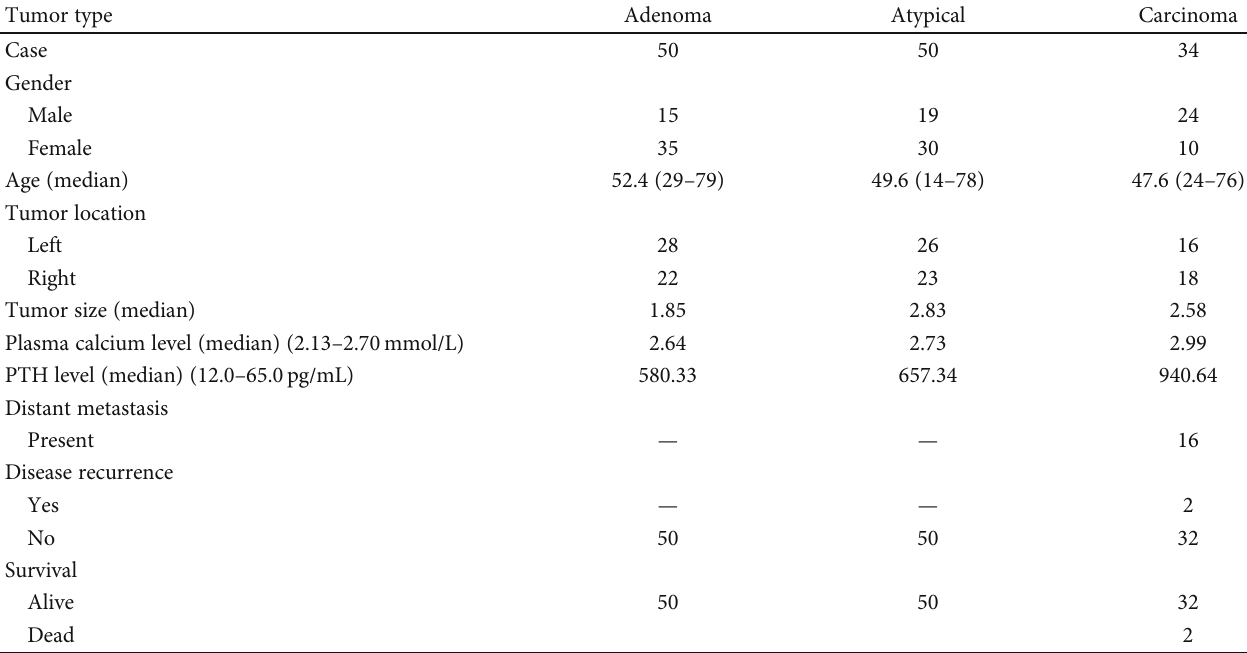
Table 1: Clinical features of the 134 patients with parathyroid tumors included in this